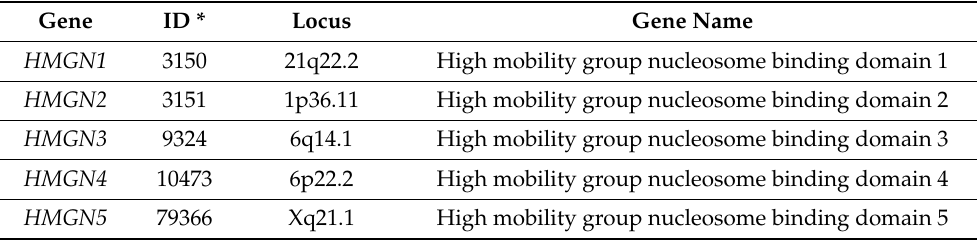
Table 1. Description of gene data of five encoding human high mobility binding nucleosome group proteins (HMGN). [Source of NCBI https://www.ncbi.nlm.nih.gov/gene/ (accessed